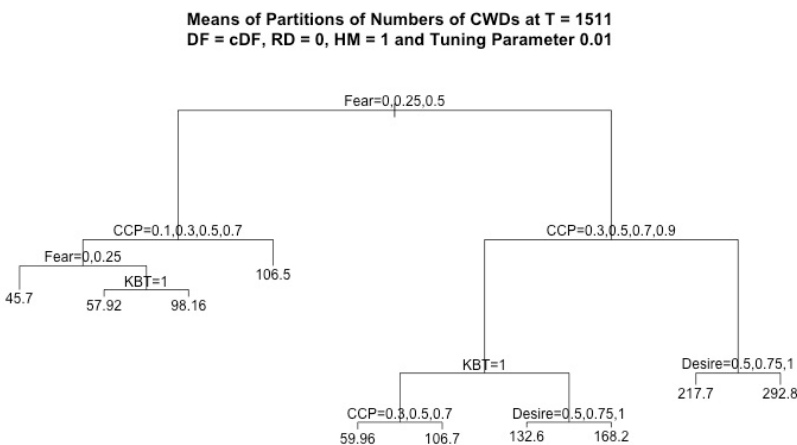
Figure 6. Tree model for means of partition numbers of CWDs at the simulation end with parameters RD = 0, HM = 1, and tuning parameter = 0.01, when agents used cDF. For each node, the left branch is conditional on the node being